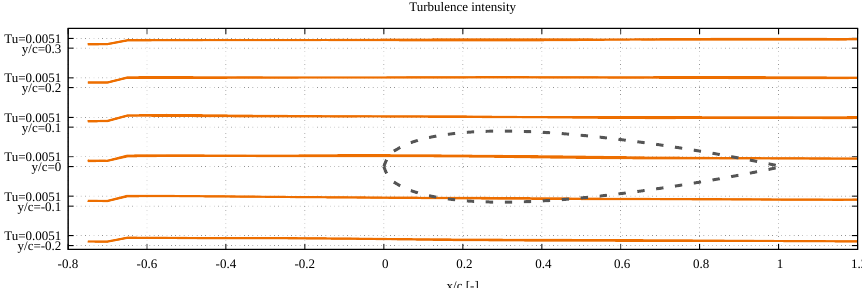
Figure 4. Development of fluctuation intensity along an empty domain. The dashed lines indicate where an object like an airfoil could have been placed.